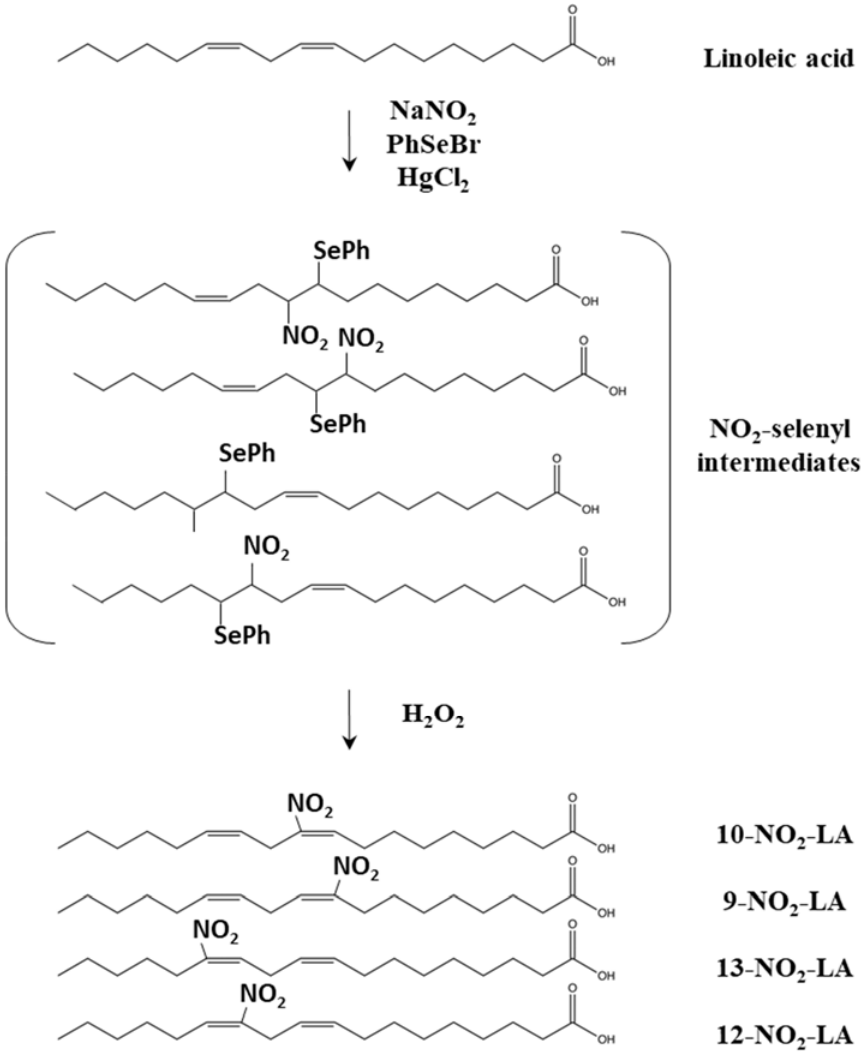
Figure 3. Synthesis of NO 2 -LA via nitro selenation/nitromercuriation reaction, which involves 2 steps: double bond activation and oxidation, and yields an equimolar distribution of nitrated regi- oisomers.